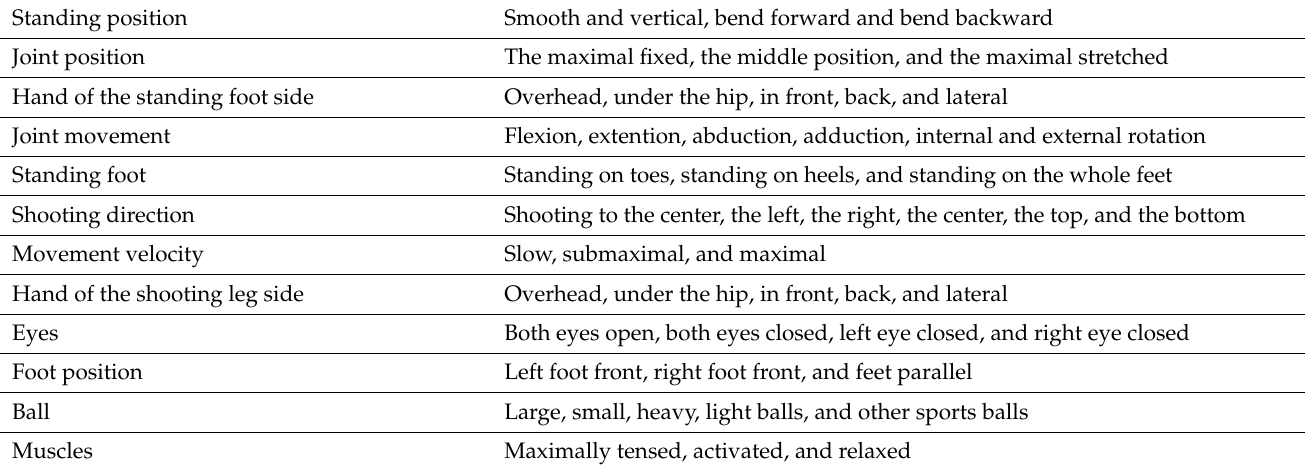
Table 3. DL Exercises